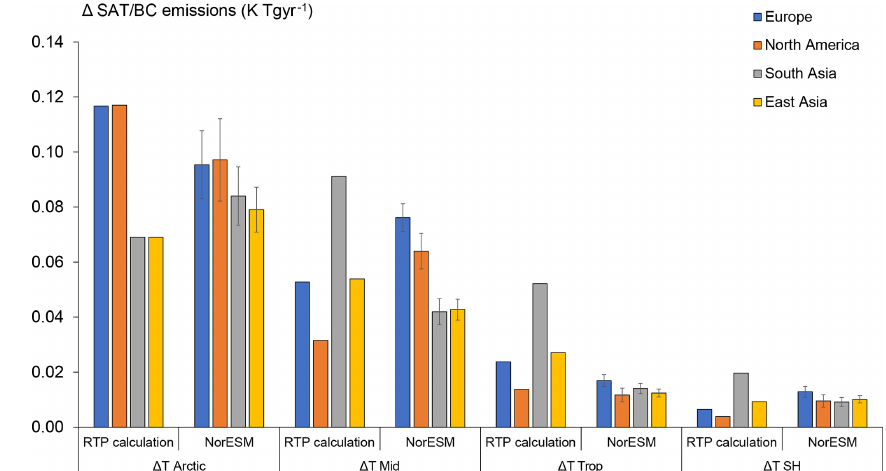
Figure 7. A comparison between ARTP-calculated and NorESM-calculated regional surface temperature response per unit BC emissions (K per Tgyr − 1 ). The lowest emission perturbation is shown here (10 × Europe, 10 × North America, 10 × South Asia, 5 × East Asia). The response region (latitude band) is given on the x axis. The error bars for NorESM represent the standard error of the